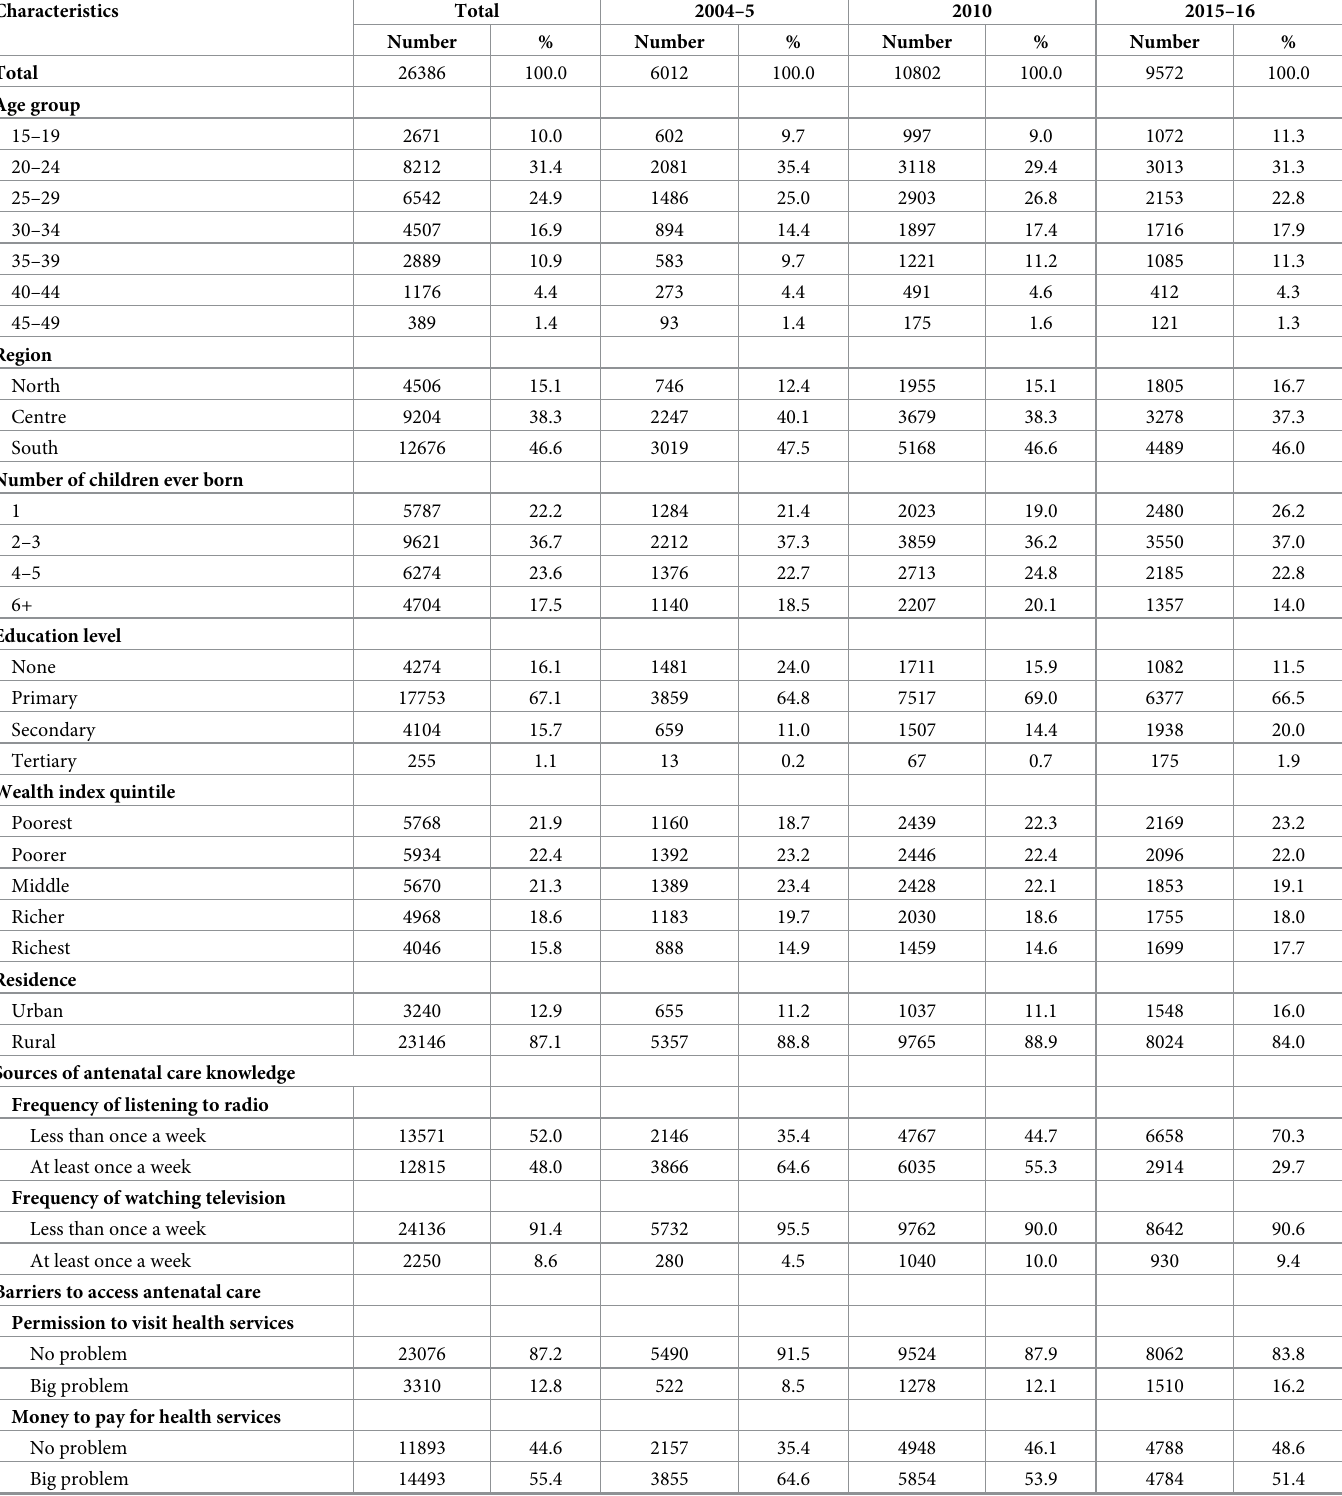
Table 1. Characteristics of women interviewed during the Malawi Demographic and Health Surveys conducted between 2004 and 2016.